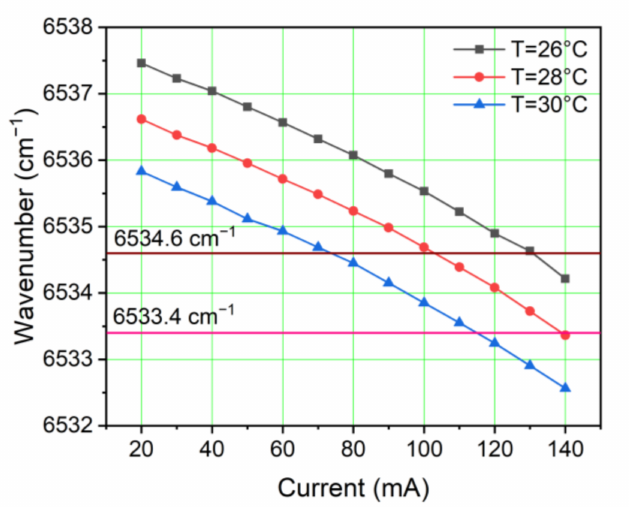
Figure 1. Emission characteristic of the 1530.33 nm CW-DFB diode laser.